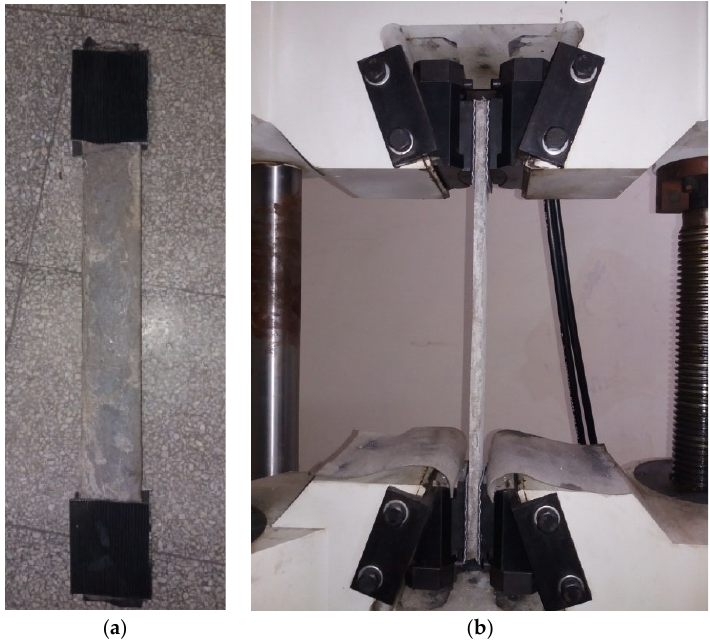
Figure 6. Casting of textile ‐ reinforced mortar specimens ( a ) first layer of mortar, ( b ) placement of fabric strip, ( c ) second layer of mortar, ( d ) de ‐ molded specimen.